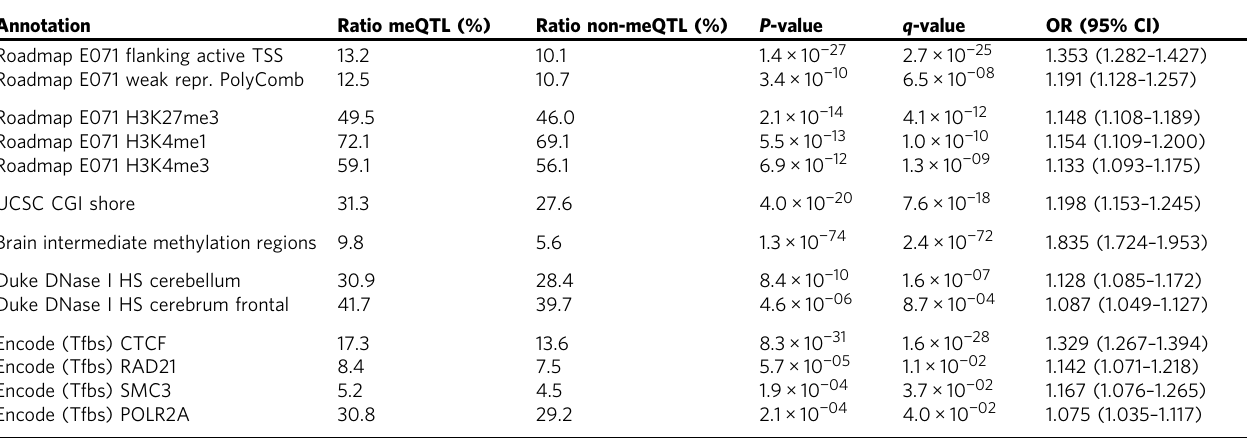
Table 1 Enrichments of 14,118 cis -meQTL-CpGs in regulatory genomic elements